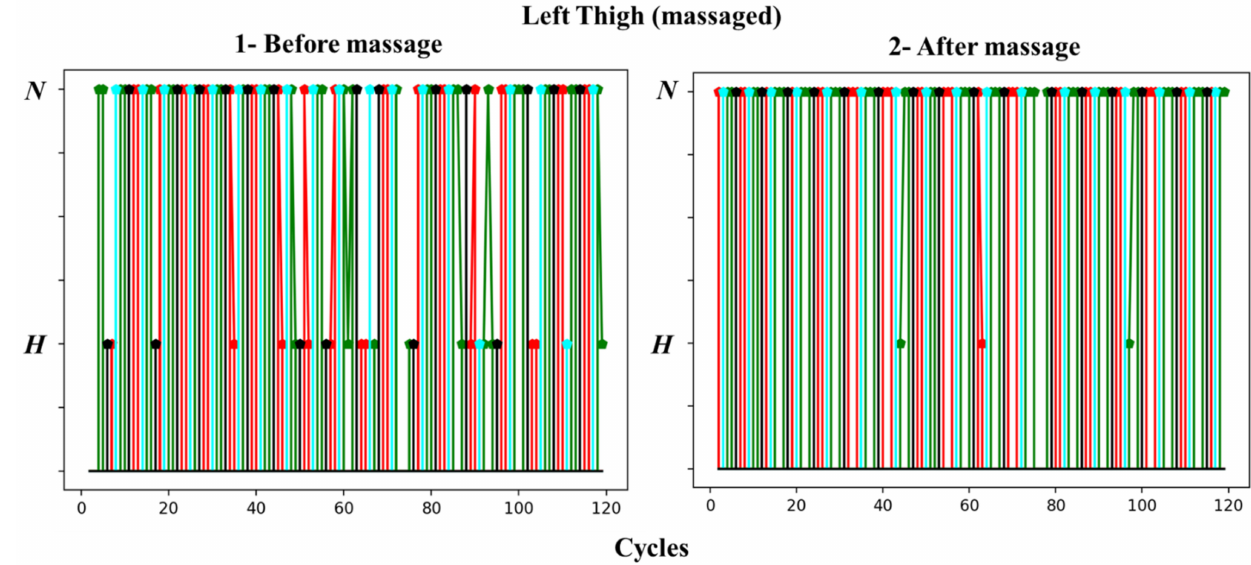
Figure 9. Changes in vascular tone for 120 cardiac cycles in the left thigh (massaged) before and after massage.